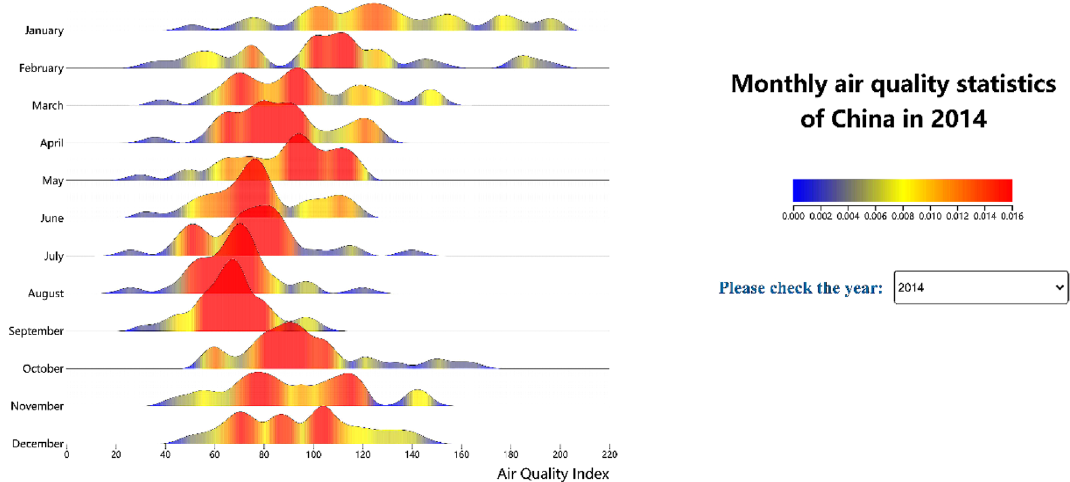
Figure 2. Ridgeline chart of the air quality